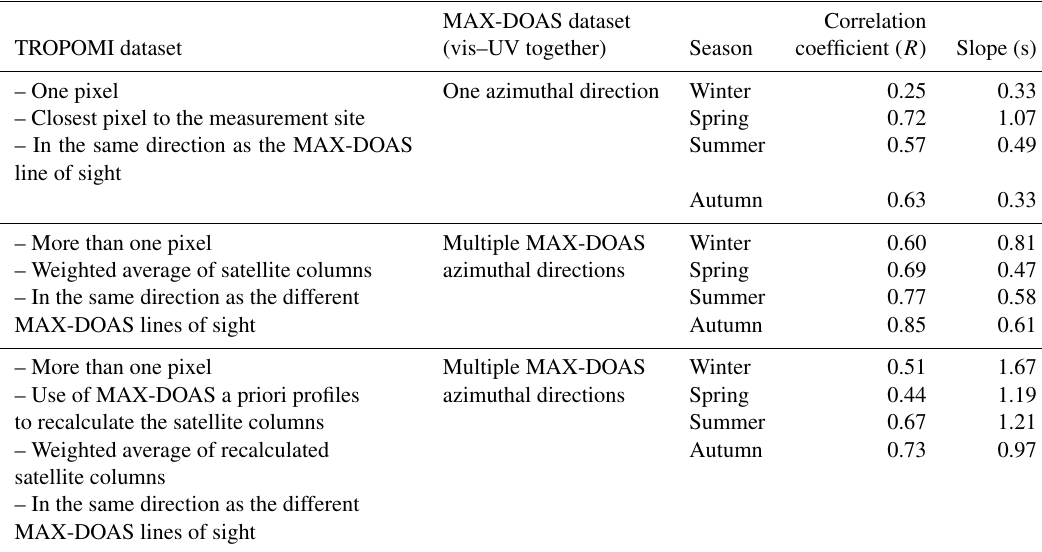
Table 7. Summary table of the regression analysis parameters derived by the three validation exercises. MAX-DOAS